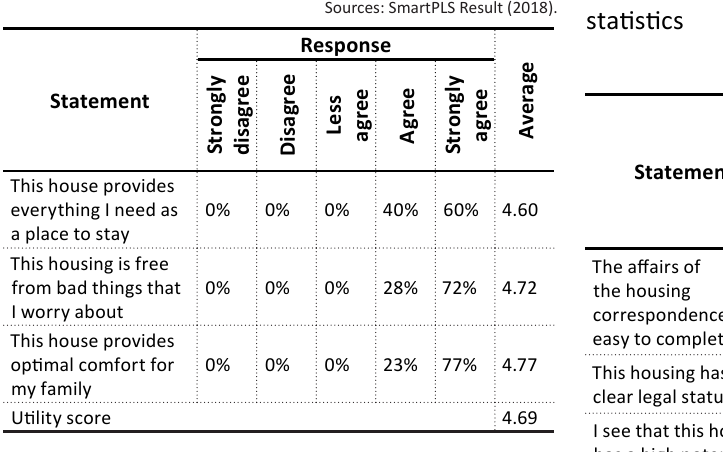
Table 8. Utility construct descriptive